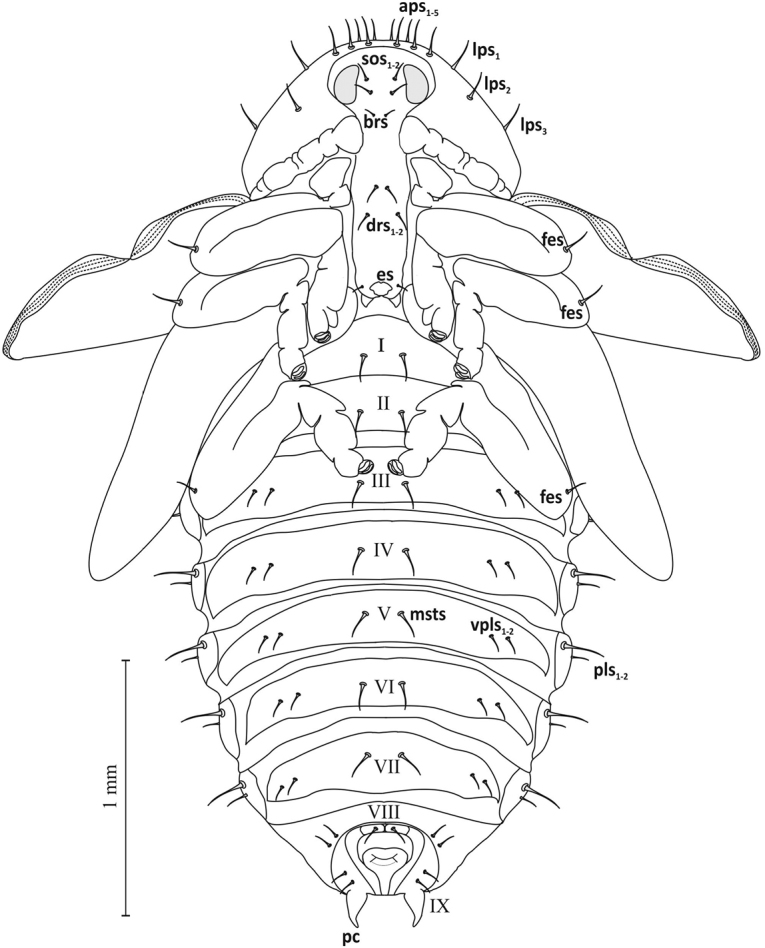
Pupa, ventral view.